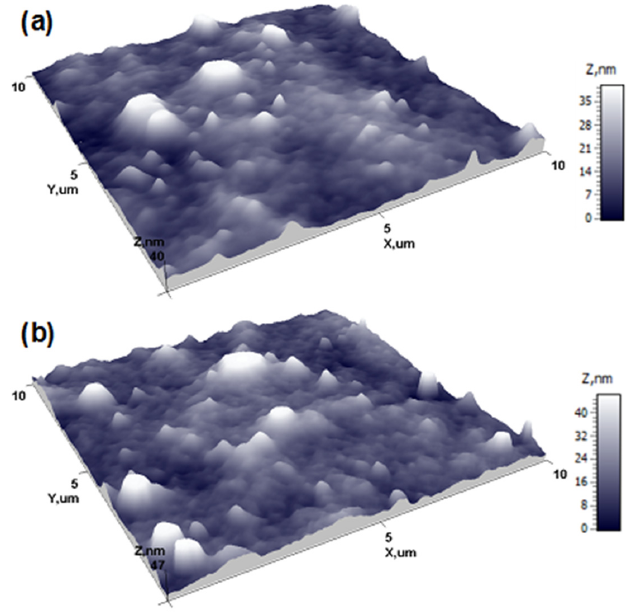
Figure 3. AFM surface topography of PEDOT:PSS film on alumina ( a ) and thiol–ene ( b ) substrates.